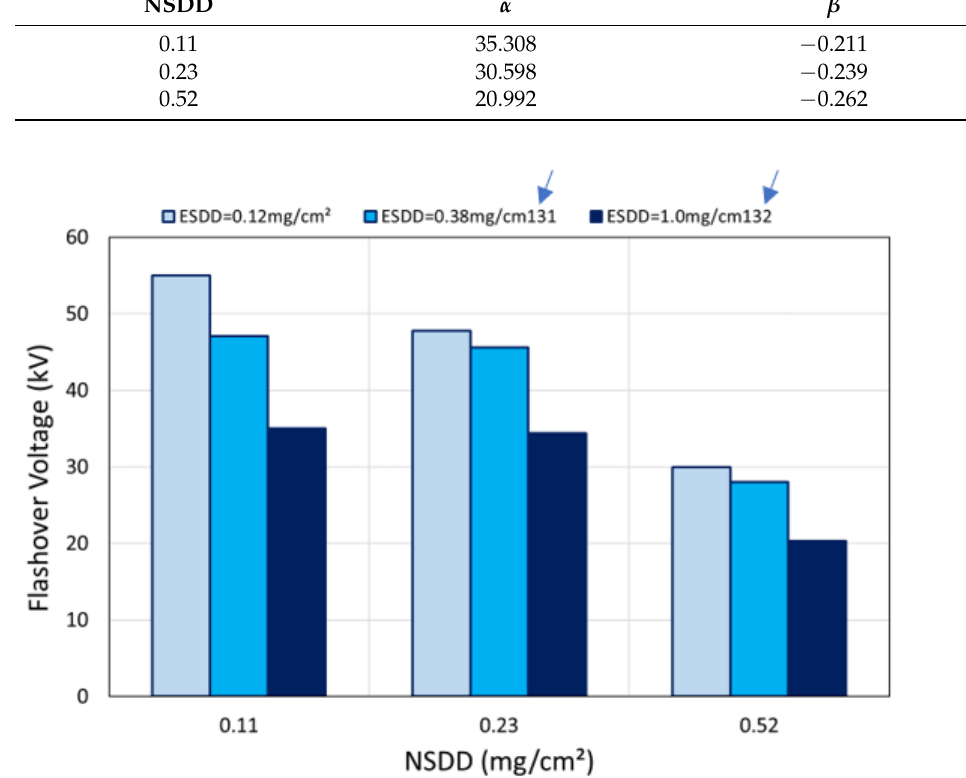
Figure 3. Effect of NSDD level on the averaged flashover voltage of the conventional insulator with different ESDD values.